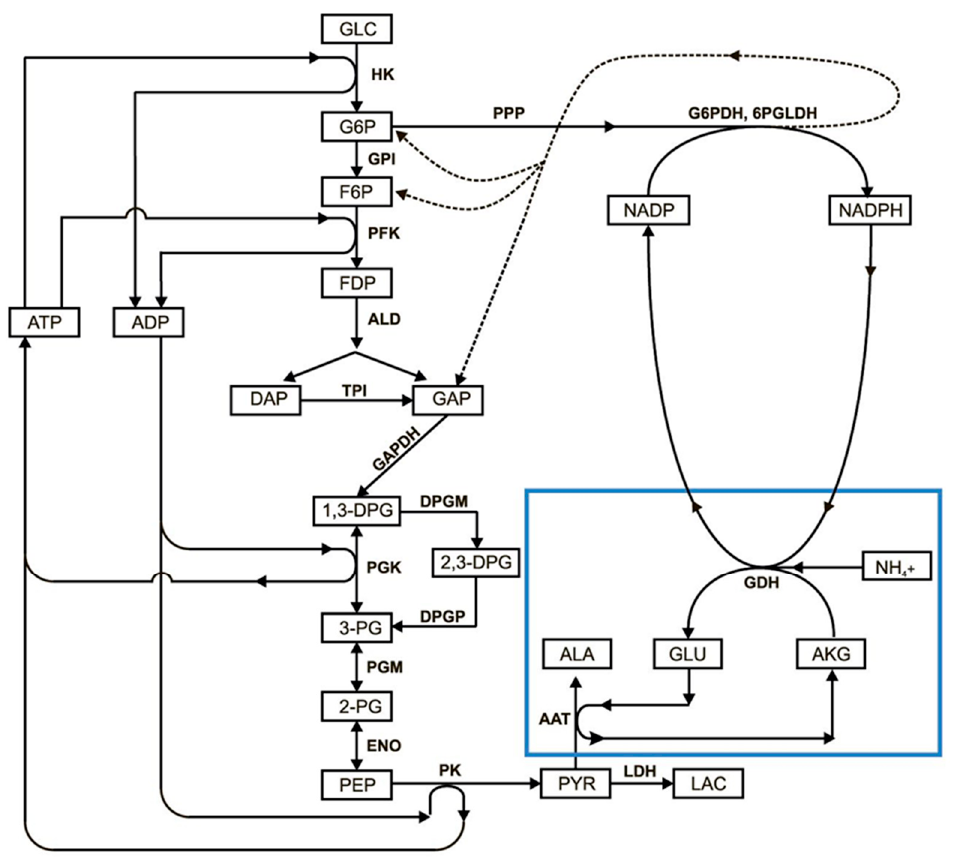
Figure 3. The glycolysis reactions and the reactions of encapsulated enzymes (GDH + AAT) in erythrocyte. The following abbreviations are used: GLC—glucose; G6P—glucose-6-phosphate; F6P—fructose-6-phosphate; FDP—fructose-1,6-di- phosphate; DAP—dihydroxyacetone phosphate; GAP—glyceraldehyde phosphate; 1,3-DPG—1,3-diphosphoglycerate;